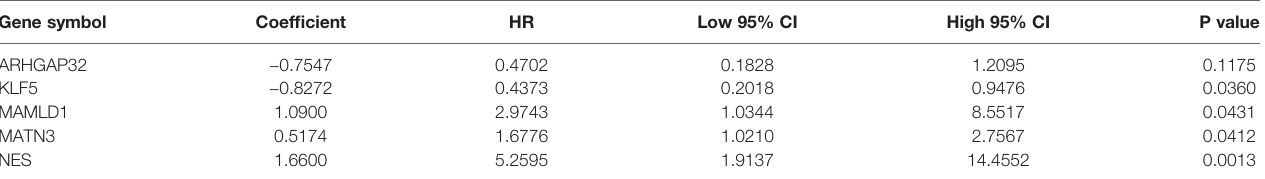
TABLE 1 | The multivariate Cox regression